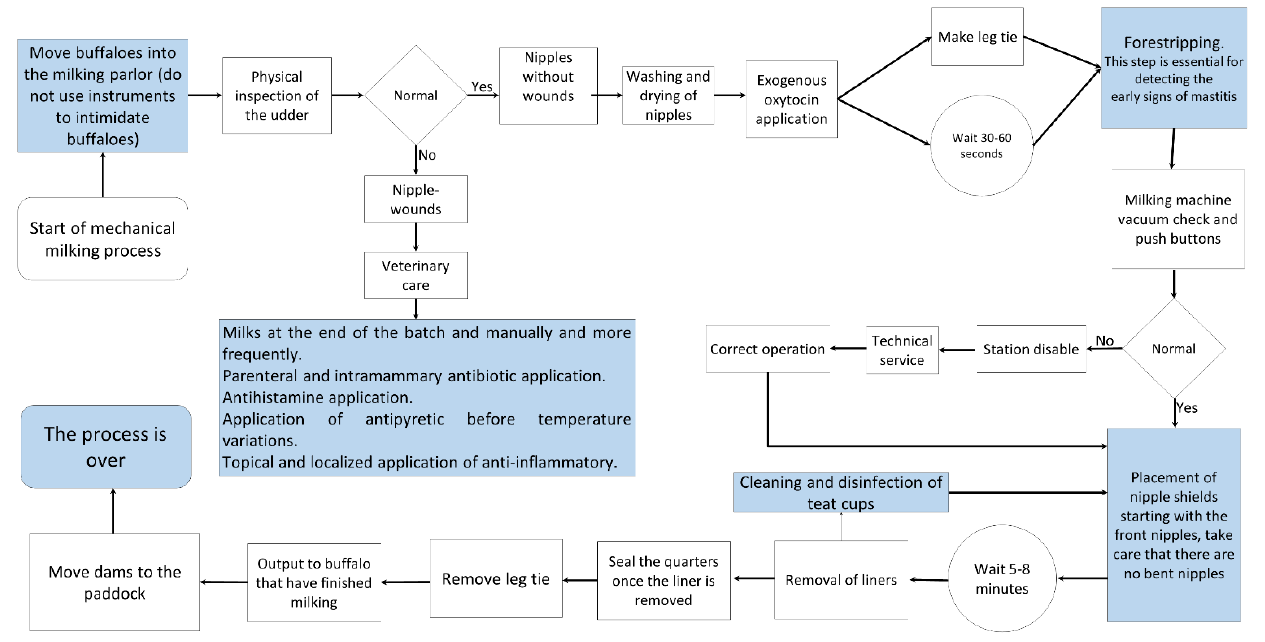
Figure 9. Flow chart of the characteristics of the mechanical milking process. In the dual-purpose production system, the presence of clinical or subclinical mastitis is low; however, when it occurs, veterinary attention is